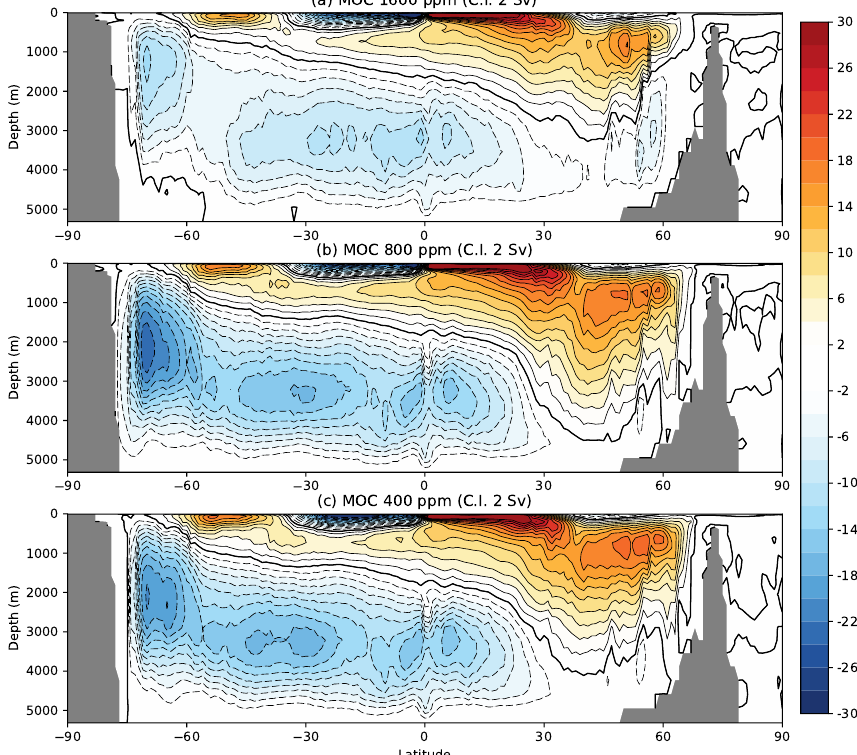
Figure 14. Global meridional overturning circulation (MOC) for CO 2 levels of (a) 1600ppm, (b) 800ppm and (c)